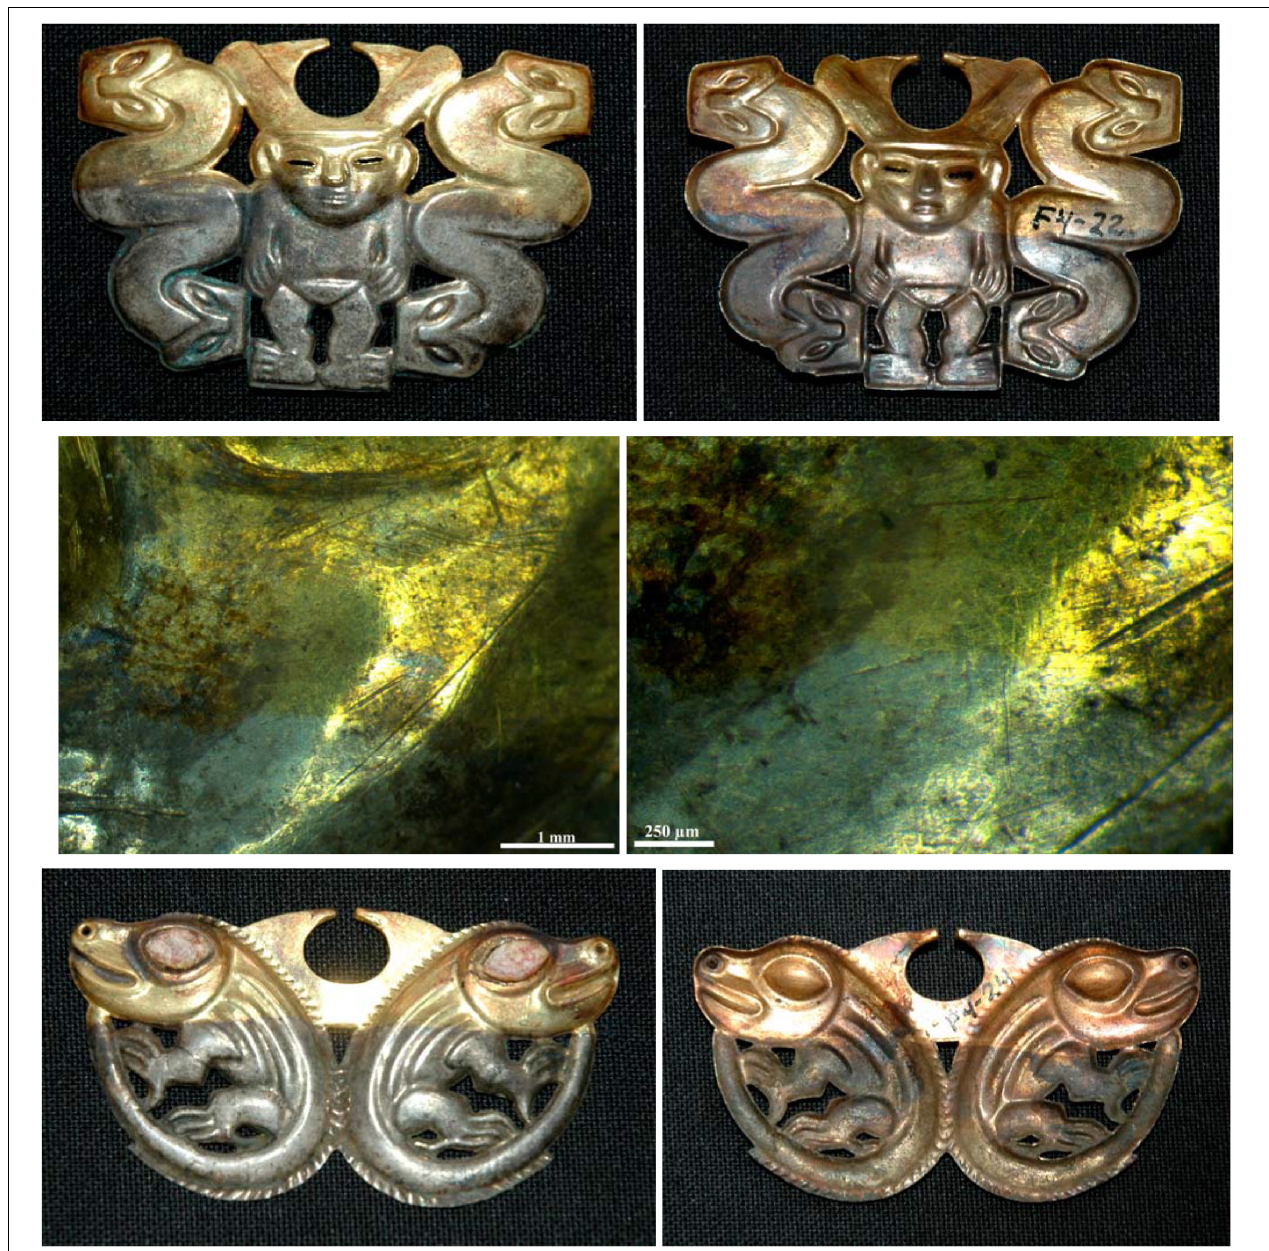
FIGURE 4 | The front and back of the nariguera F4-22 from the tomb of the Lady of Cao and optical images of the interface between the gold- and the silver-enriched areas, on the first and second rows, respectively. In the third row is shown the front and back of the nariguera F4-24. The images of the narigueras clearly reveal the color change from the “silver” and “gold”